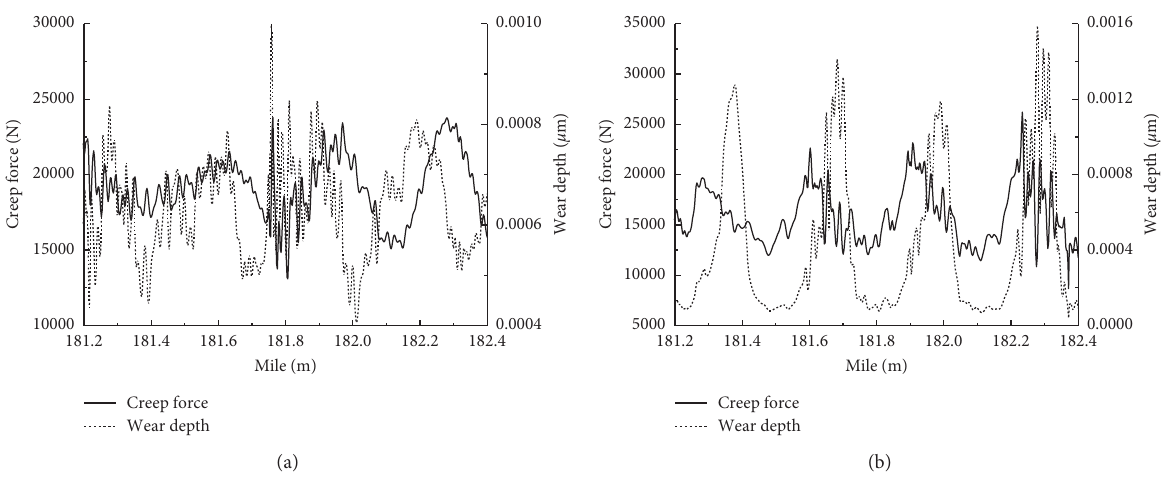
Figure 6: Creep force and wear depth. (a) Outer rail. (b) Inner